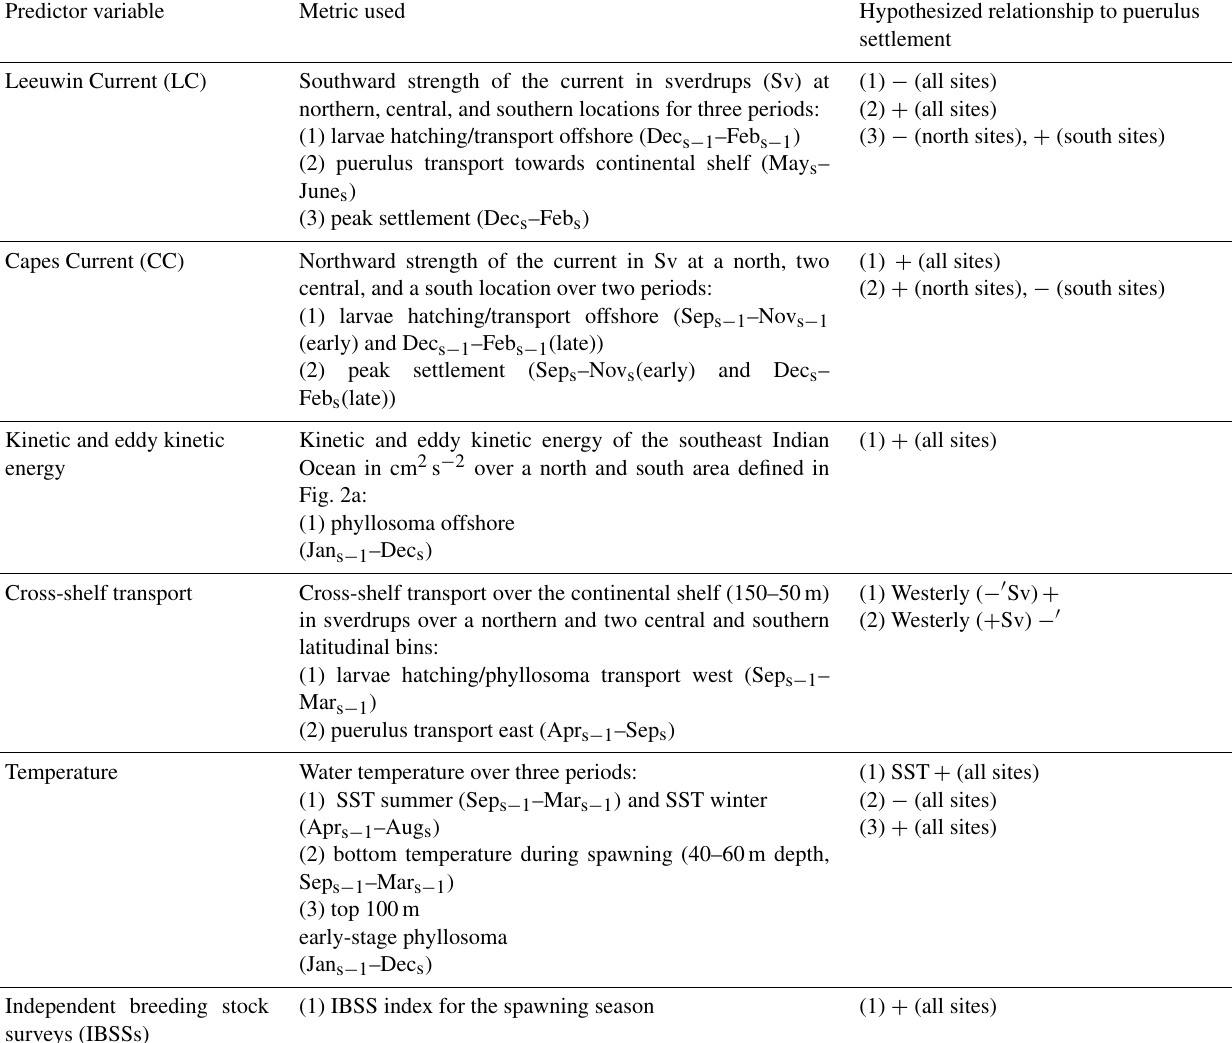
Table 1. Predictor variables and metrics used in the GAM analysis to investigate variability in puerulus settlement and associated hypothesis. The subscript s identifies the relativity of a month to the puerulus settlement season (May–April) in question. s − 1 is within the season prior and s + 1 is after. − denotes a negative relationship, and + denotes a positive